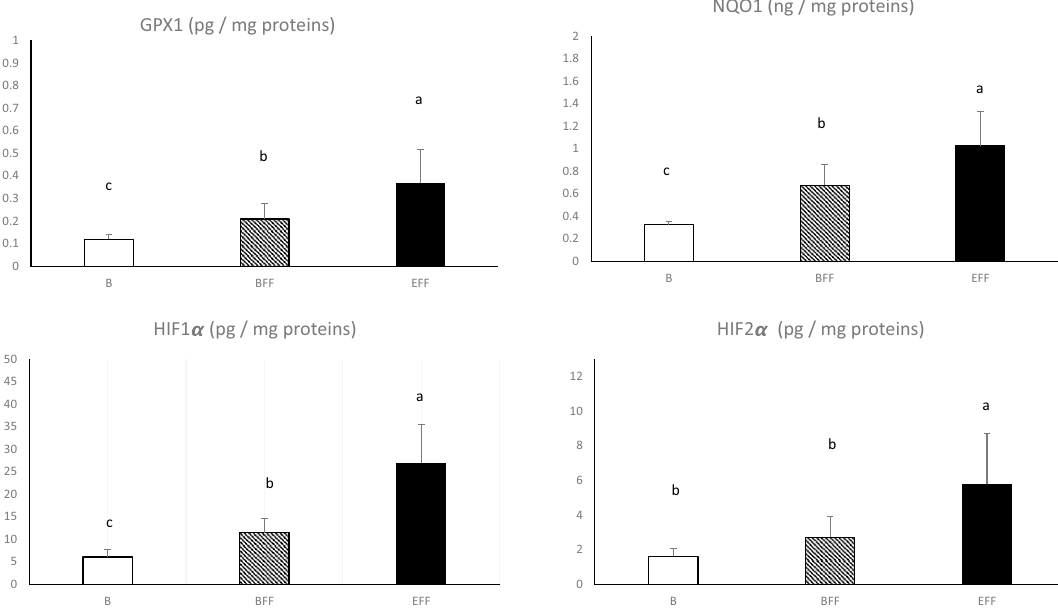
Figure 2. Biochemical contents of glutathione peroxidase 1 (GPX1), nicotinamide adenine dinucleotide (phosphate) hydrogen dehydrogenase (quinone) 1 (NQO1), hypoxia inducible factor 1 alpha (HIF1α) and hypoxia inducible factor2 alpha (HIF2α) in livers collected before (B) or at the beginning (BFF) or at the end (EFF) of the force-feeding period. Values are means ± SD. Bars with different letters differ (p <